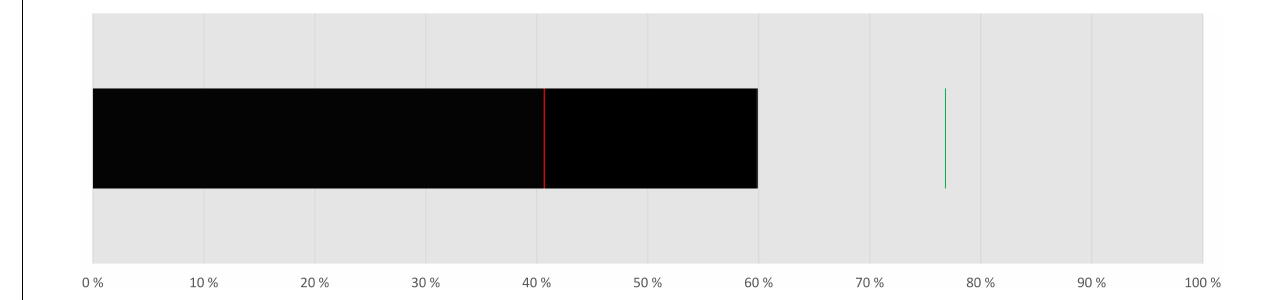
FIGURE 2 | Medium ACC as hit rate in percent. The red line indicates the lowest and the green line the highest individual hit rate. TABLE 1 | ACC (and SD ) and hit rates for the different angles of rotation.